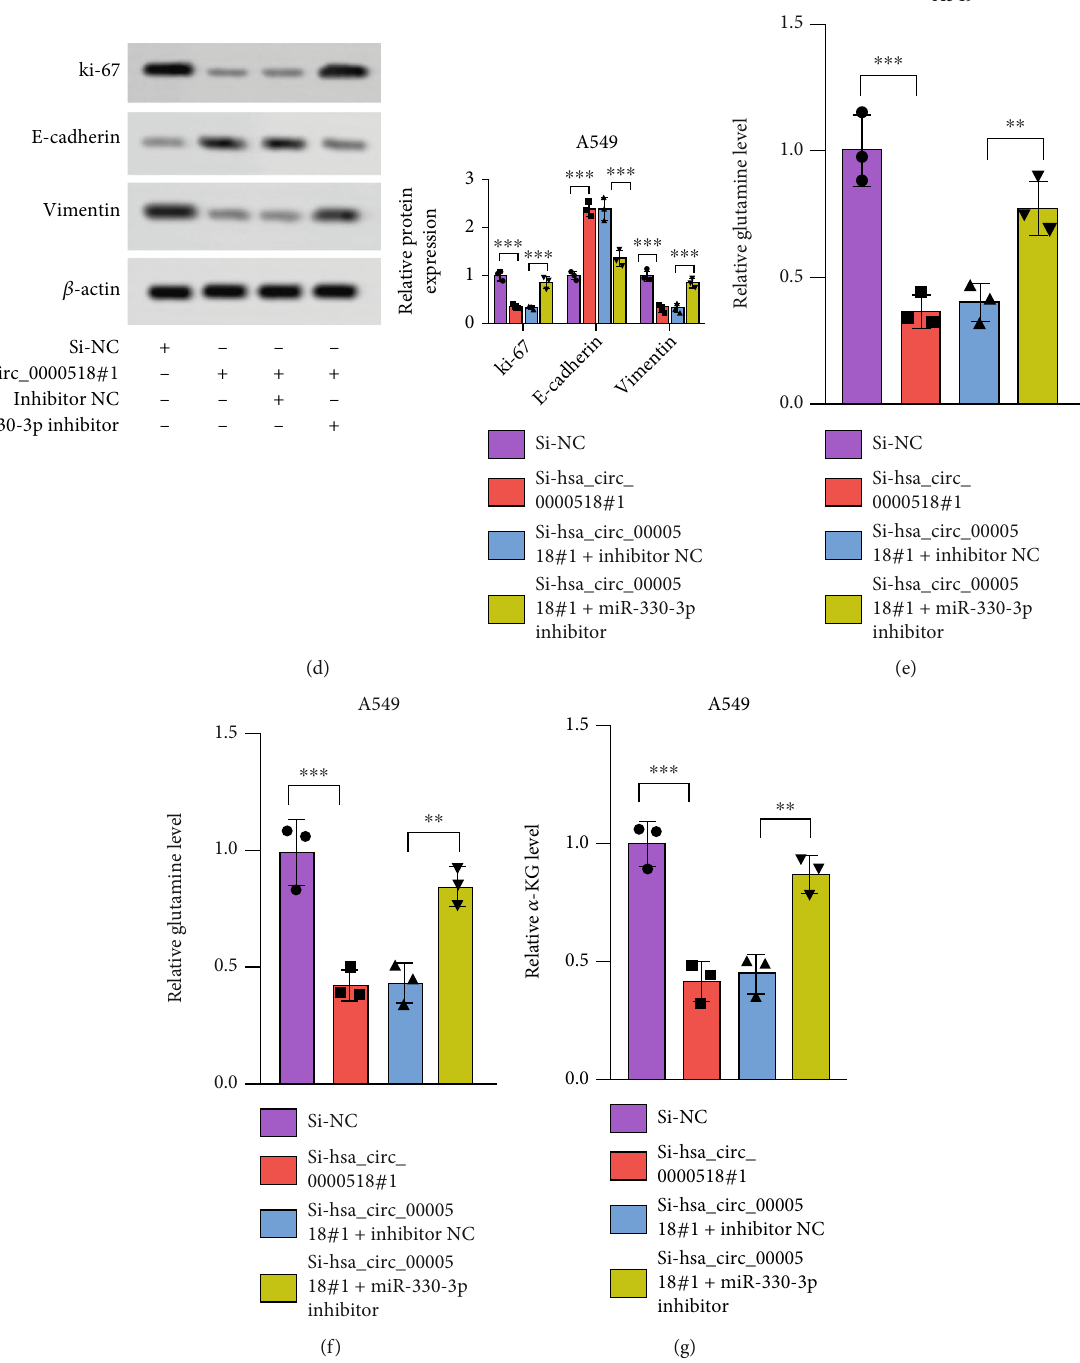
Figure 4: Downregulation of miR-330-3p contributes to inhibition of proliferation, invasion, and glutamine metabolism of NSCLC cells. (a) Transfection e ffi ciency of miR-330-3p inhibitor determined using qRT-PCR. (b) CCK-8 assays were performed in cells stably transfected with NC or si-circ_0000518, with or without the miR-330-3p inhibitor. (c) Transwell invasion assays with A549 cells stably transfected with the NC vector or si-circ_0000518, with or without the miR-330-3p inhibitor. (d – g) Ki-67, E-cadherin, and vimentin levels in A549 cells. ∗∗ p < 0 : 01 , ∗∗∗ p < 0 : 001